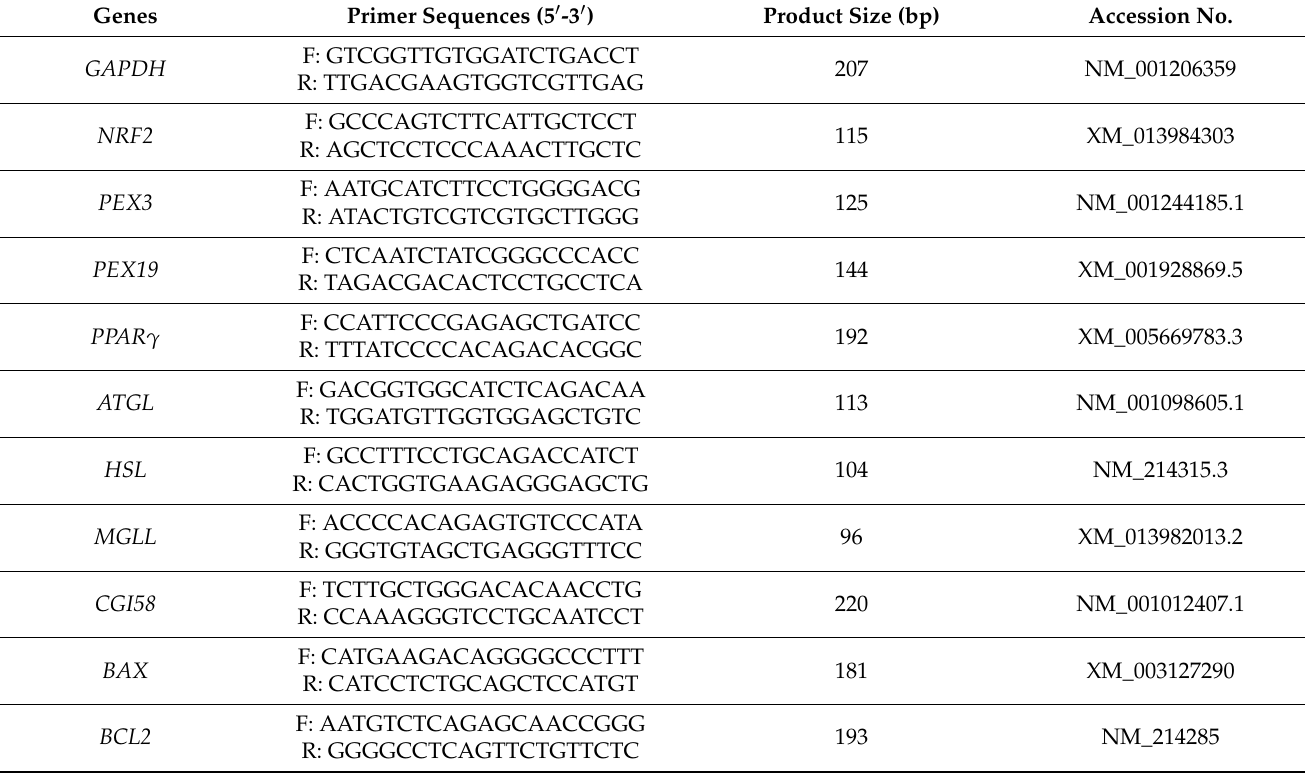
Table 2. Sequence-specific primers used for quantification of differential expressed transcripts.